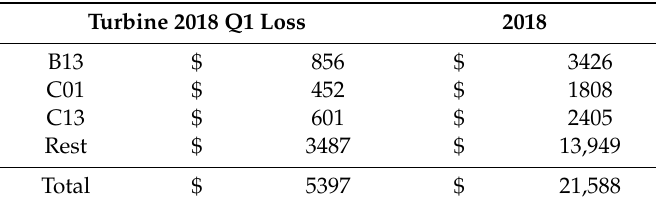
Table 4. Projected Economic loss 2018 for the selected wind